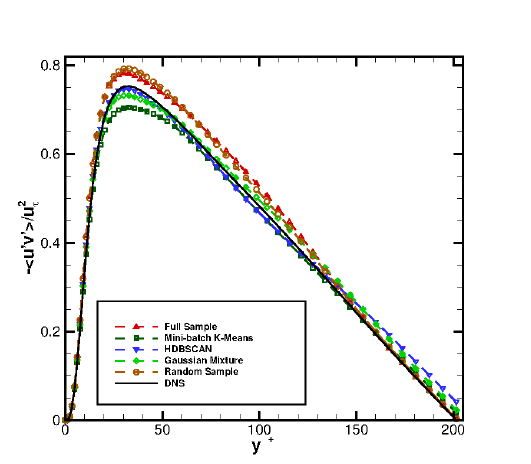
Figure 12. Re τ = 200 turbulent channel flow: Ritz values.